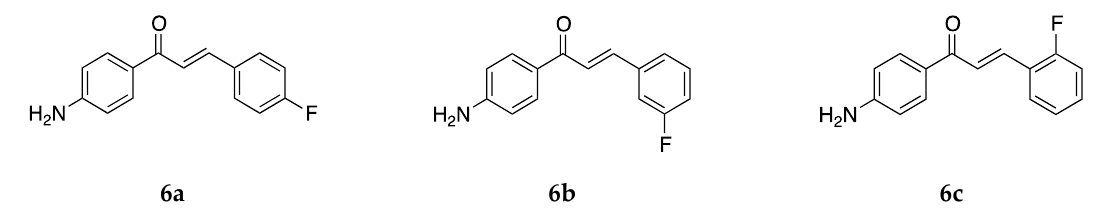
Figure 8. Chemical structures of 4-aminochalcone derivatives with fluoro substitutions on ring B.